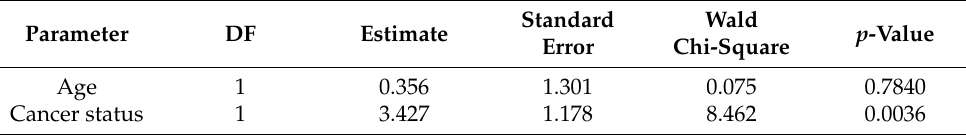
Table 5. Analysis of maximum likelihood